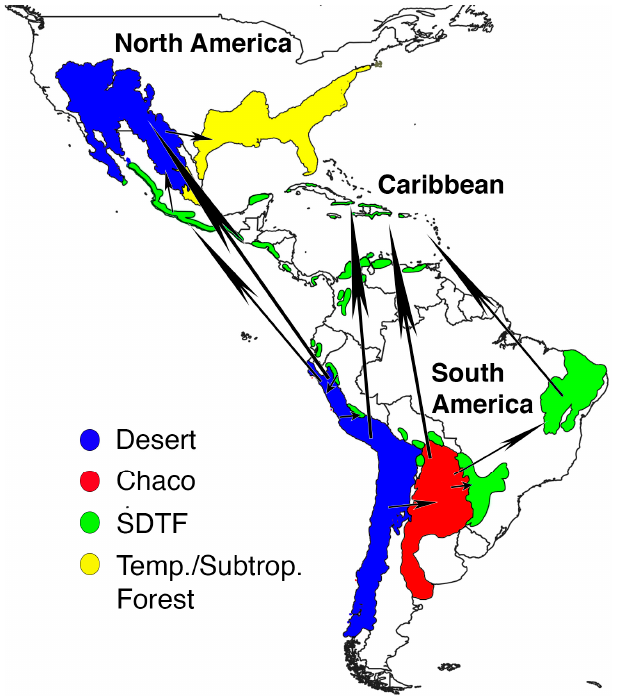
Figure 4. Map of putative dispersal events of Cactaceae across the Americas. Arrows indicate the directionality of dispersal. Cactaceae originated in arid areas of South America, and there were movements between the desert and SDTF on several occasions. Numerous dispersals occurred out of South America into the Caribbean region from the desert, Chaco and SDTF and into western North America, mostly from desert habitats. Movement from the desert to the Chaco and then into SDTF occurred within South America, and movement from SDTF to desert and desert to temp./suptrop. forest occurred in North